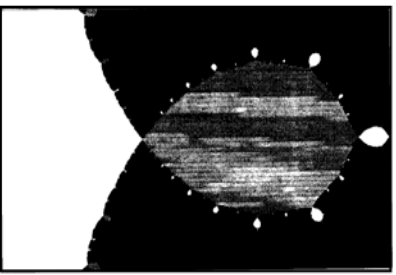
Figure 1. Newton basins for